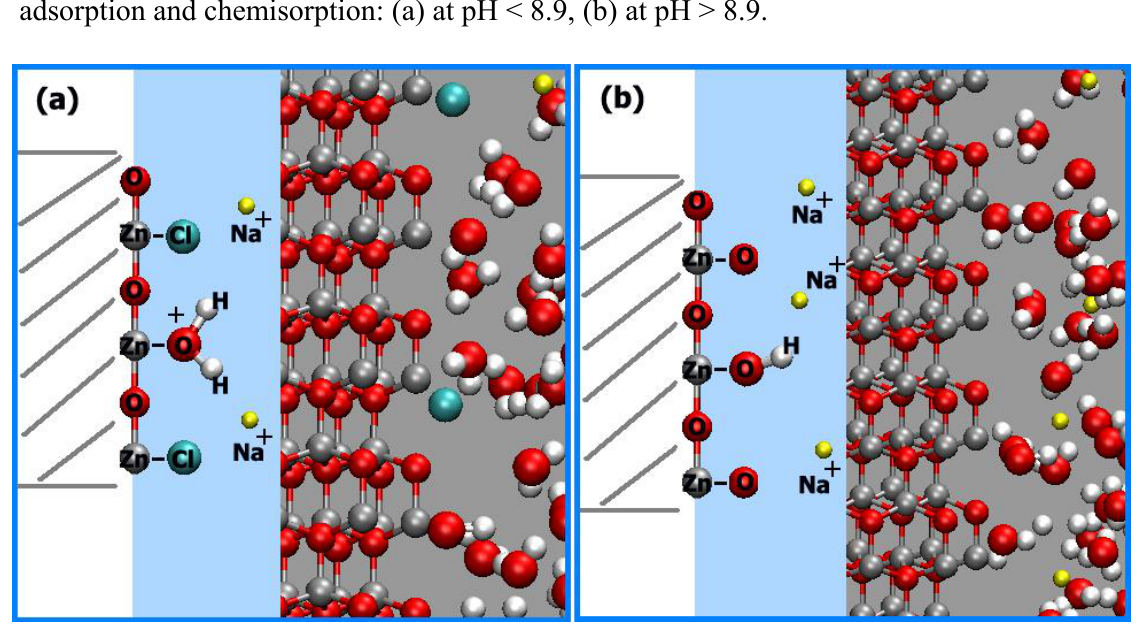
Figure 19. Schematic representation of the charges transferred to the ZnO by primary adsorption and chemisorption: (a) at pH < 8.9, (b) at pH > 8.9.